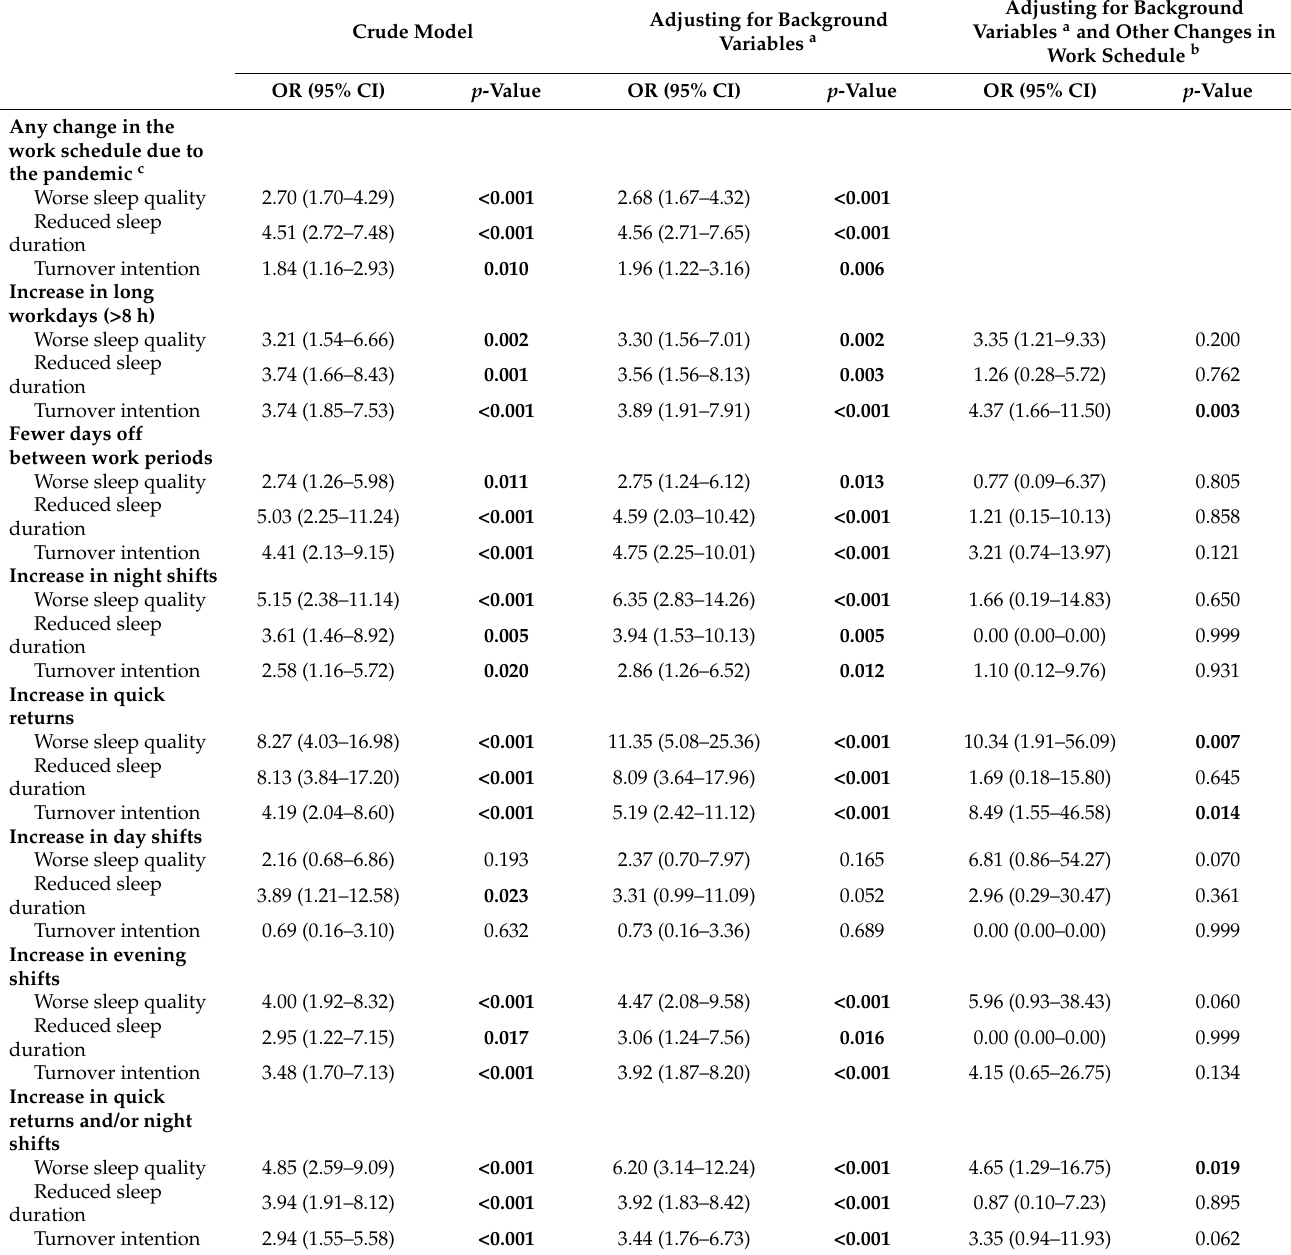
Table 3. Results from logistic regression analyses on the association between change in work schedule and change in sleep quality, change in sleep duration, and turnover intention ( n = 694).